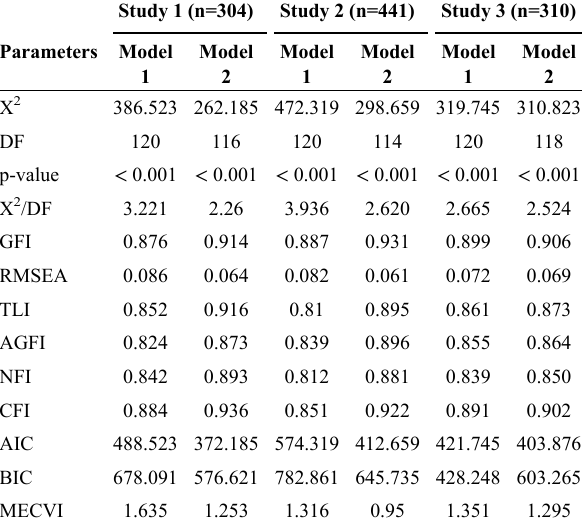
Table 1 - Confirmatory Factor Analysis for the three studies with the SMS-II.